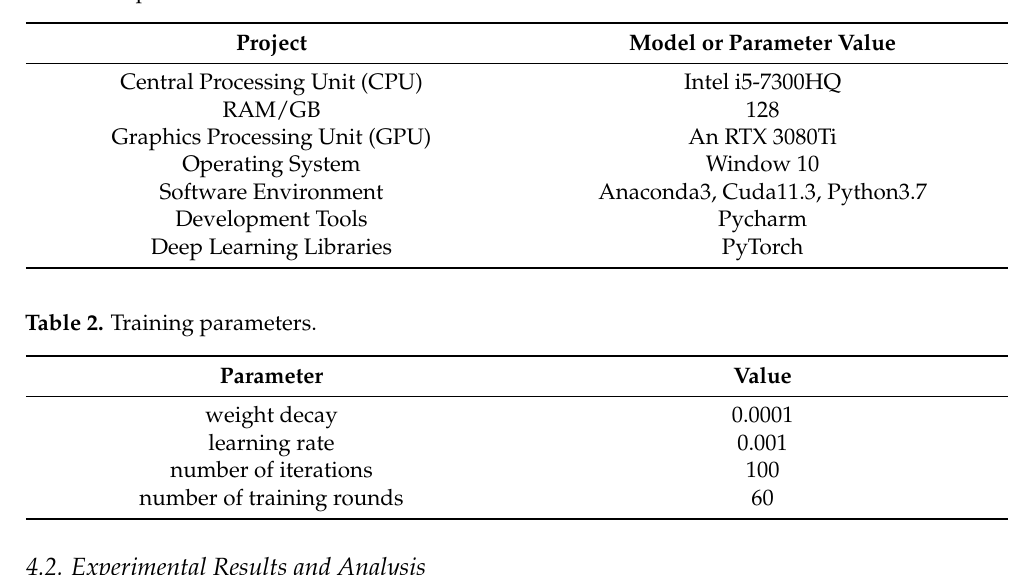
Table 1. Experimental environment.